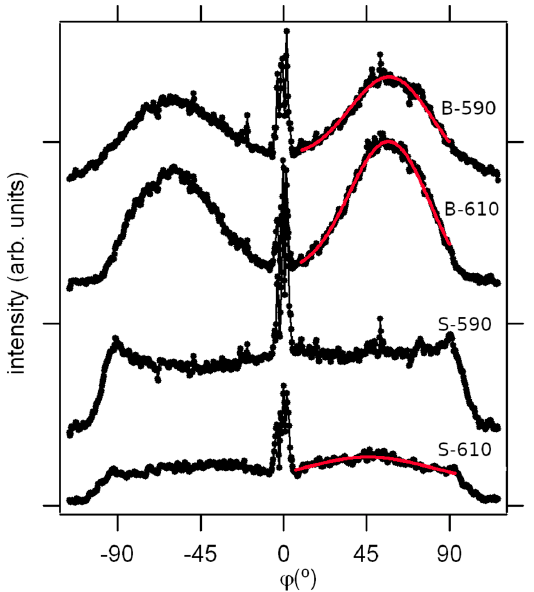
Figure 6. All angle (circular) section ( q y 2 + q z 2 = const.), taken over semi-circular path marked in Figure 5, indicating the preferred orientation. Red lines are the Gaussian fits.